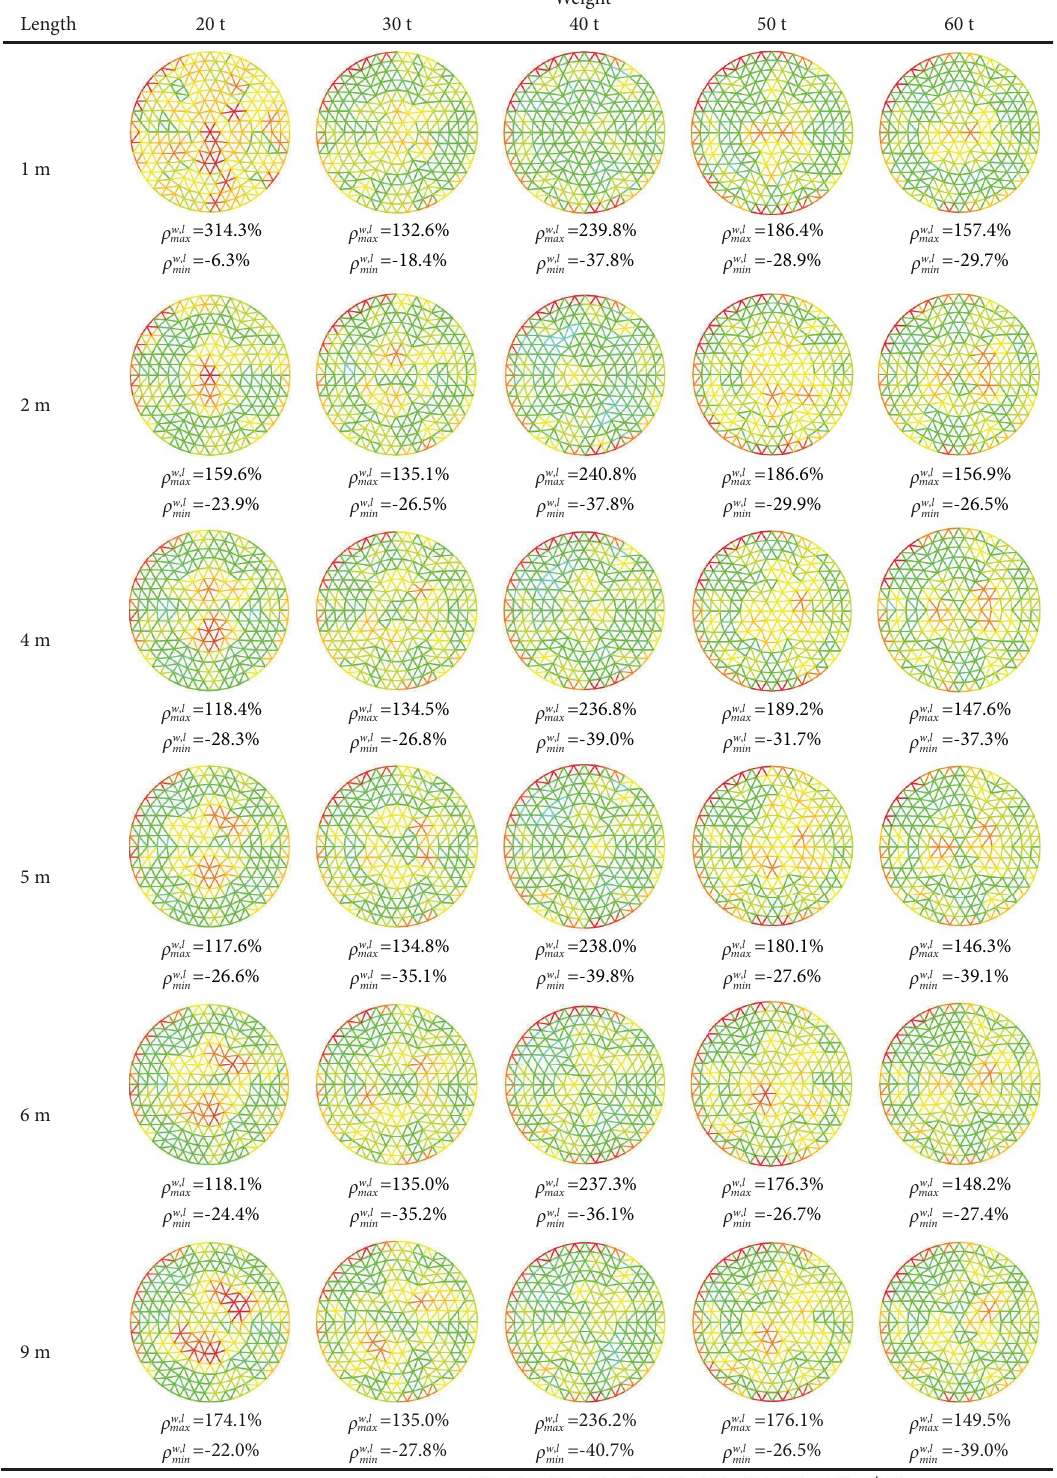
w,l , and ρ w,l values in the z i, max , ρ min max